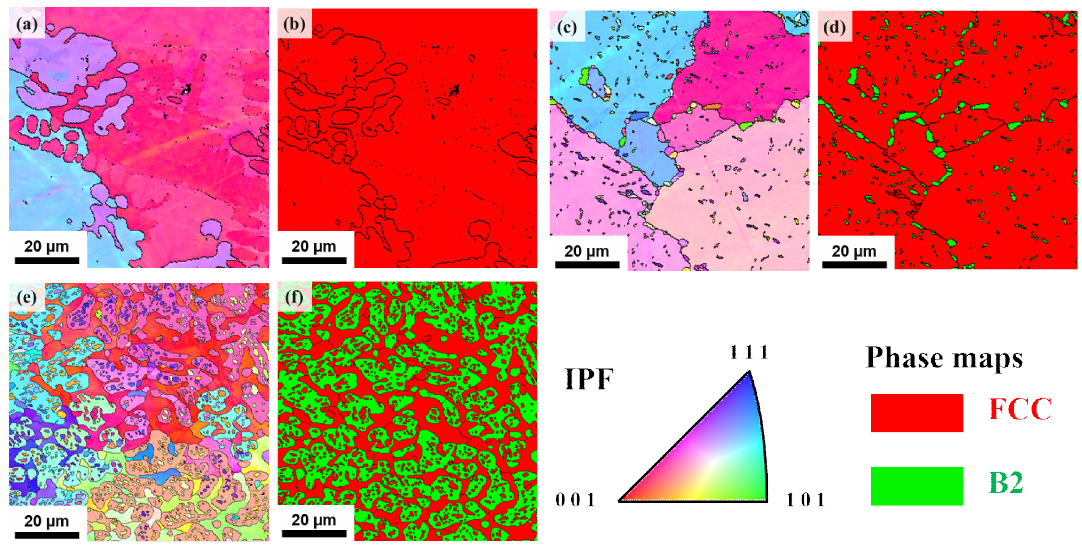
Figure 4. Inverse pole figure (IPF) and phase maps of ( a , b ) the 2.5Al, ( c , d ) 10Al, and ( e , f ) 15Al alloys.